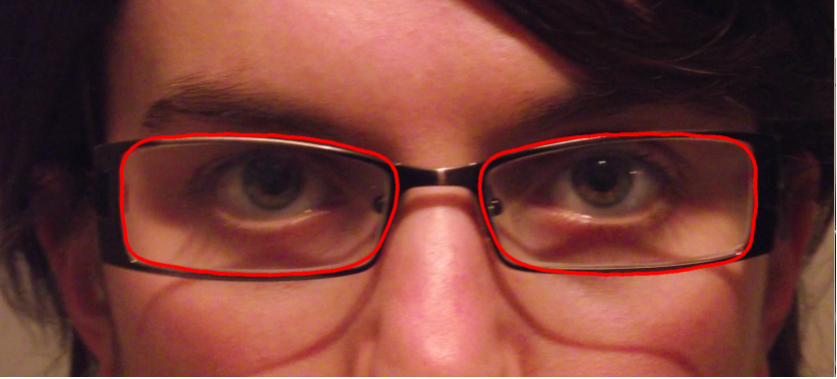
Figure 9. Final result of the algorithm. The extracted lenses contours are marked in red in the